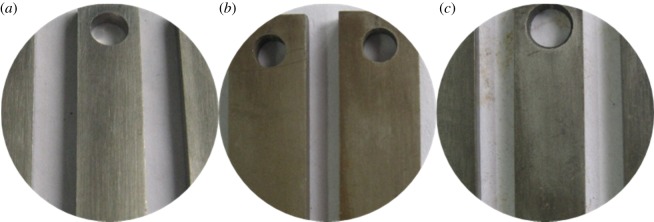
Corrosion morphology at H2S content of 2000 ppm. (a) G3, (b) N80 and (c) P110SS.